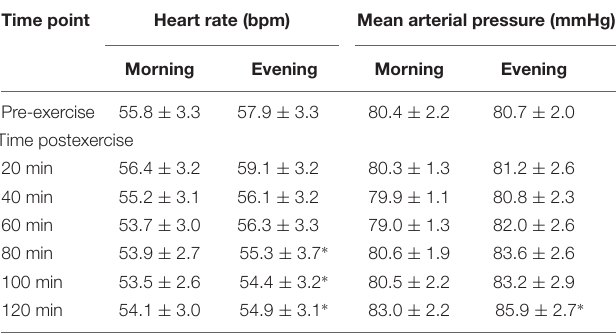
TABLE 2 | Central hemodynamics pre- and post-exercise performed in the morning and the evening.